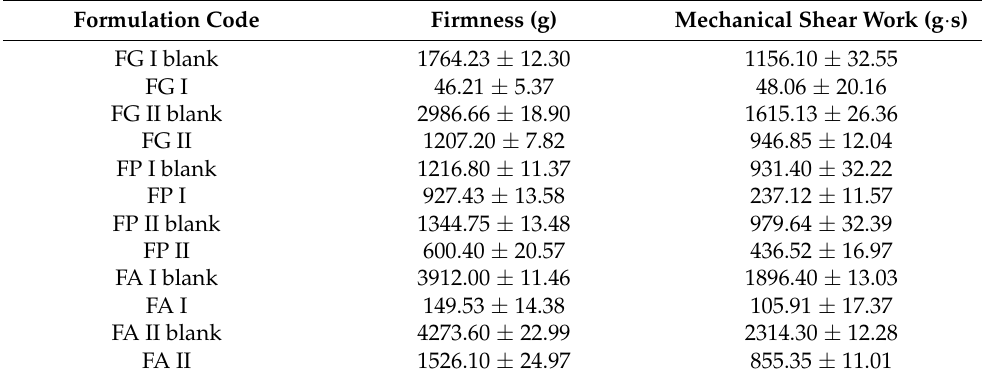
Table 5. Parameter values measured during testing the ability to display experimental hydrogels with the texture